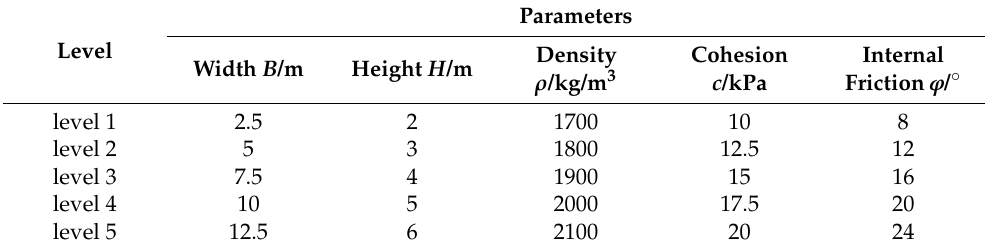
Table 4. ELB parameter values for every level.